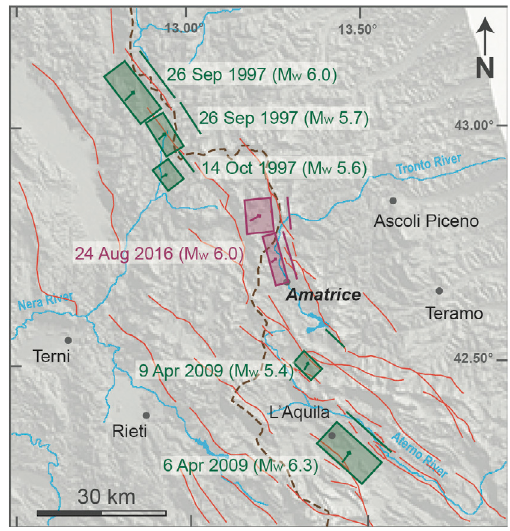
Figure 1 . Geographic setting and seismogenic sources discussed in text. Active faults from various sources are shown in red. Sources in green are from the DISS database [DISS Working Group 2015]. The two sub- sources proposed for the Amatrice earthquake, in purple, are from Gruppo di Lavoro IREA & INGV [2016]. A dashed line shows the regional